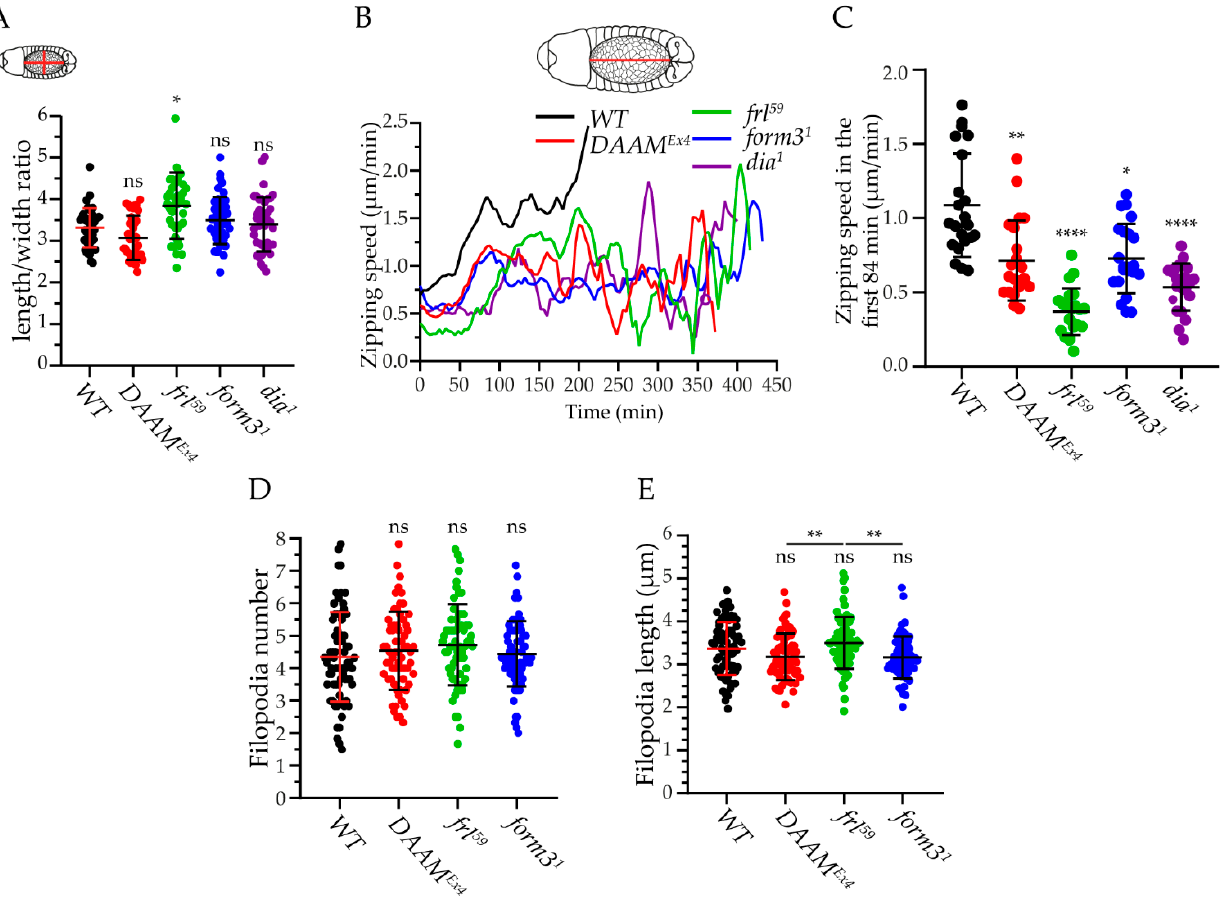
Figure 5. Formin mutants impair zipping of the dorsal hole. Arm::GFP was used as the wild-type (WT) control in A – C , whereas en-Gal4,UAS-Moe::mCherry was used as the control in D and E . ( A ) Scatter dot plot of the length-to-width ratio in formin mutants. Note that only frl 59 shows a significant difference as compared to WT, resulting in an elongated dorsal hole. ( B ) Diagram of the temporal changes of zipping speed in formin mutants. ( C ) Diagram of the average zipping speed in the first 84 min of DC (corresponding to the first, very dynamic phase of zipping in WT) in formin mutant embryos. ( D ) Scatter dot plot showing the average filopodia number per engrailed positive stripe in formin mutant embryos. ( E ) Scatter dot plot of the average filopodia length in formin mutants. Statistical analyses were performed by Kruskal–Wallis tests p < 0.0001 ( A , C ) p = 0.0005 ( E ), followed by Dunn’s multiple comparisons test ( A , C , E ) and by ordinary one-way ANOVA test p = 0.3206, followed by Dunnett’s multiple comparisons test ( D ). Mutants were compared to the WT, unless indicated otherwise. Data are presented as mean ± SD; ns = non-significant. * p ≤ 0.05, ** p ≤ 0.01, **** p ≤ 0.0001.